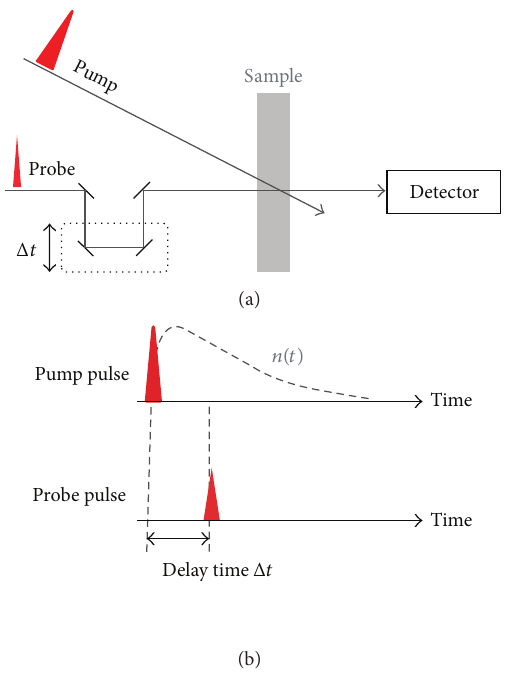
Figure 7: (a) Schematic diagram of pump-probe technique. Time delay ( Δ𝑡 ) between pump and probe pulses can be controlled by a mechanical delay line. (b) The fundamental principle of pump- probe experiments. Time varying refractive index 𝑛(𝑡) changes of the sample induced by pump pulses were observed by detecting the intensity variations of probe